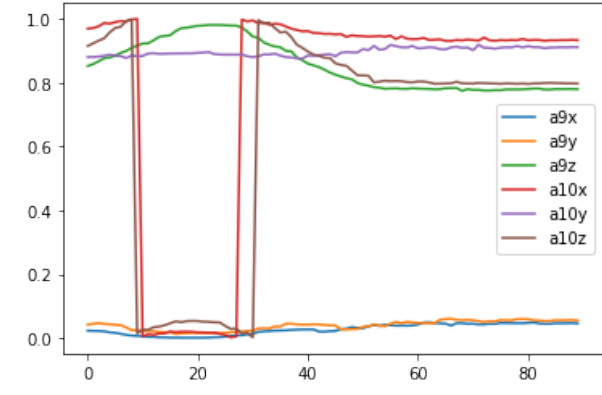
Figure 7. Rotation angles transformed to a fixed number of frames (reduced to 90 frames and normalized from 0 to 1). the input matrix. The model’s input is a matrix where each row represents one Euler angle, and the 90 columns repre- sent the reduced frames. There are 24 rows since each of the eight articulations has three Euler angles, which are named as